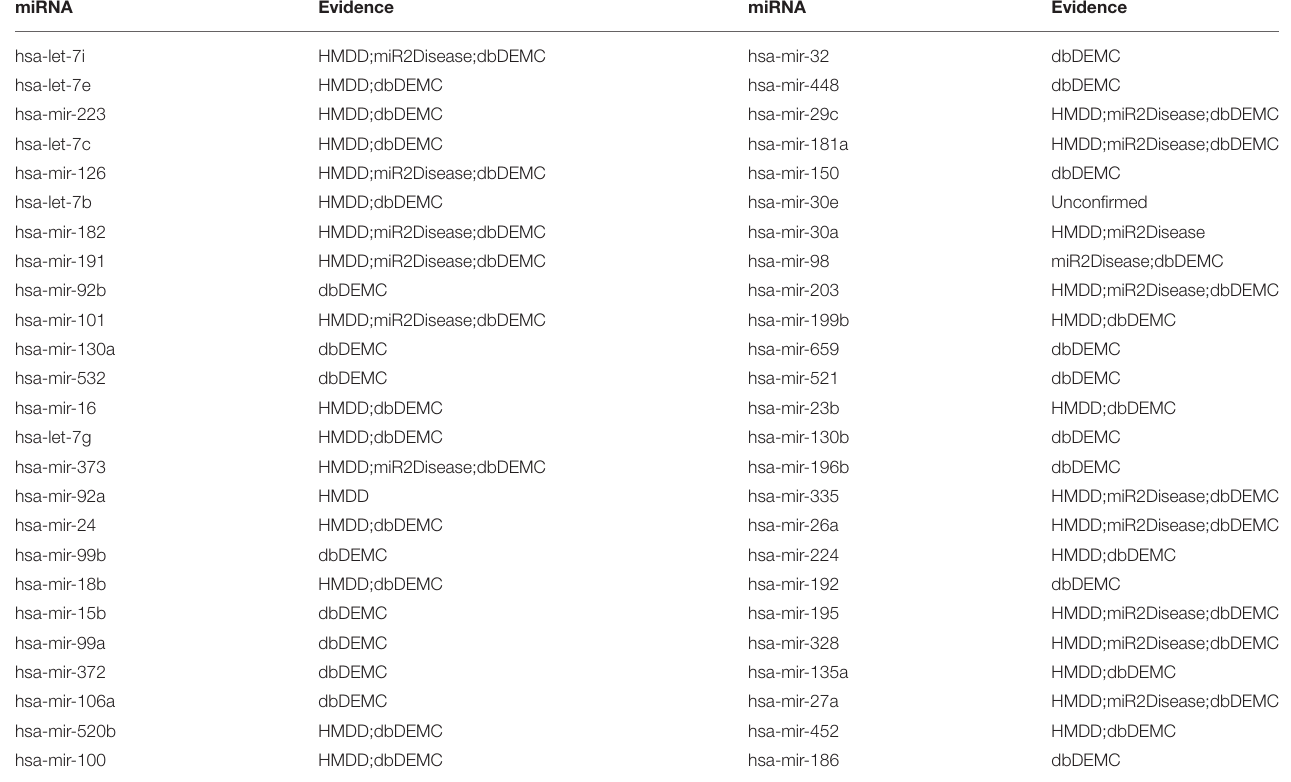
TABLE 3 | The top 50 predicted miRNAs associated with Breast Neoplasms. miRNA Evidence miRNA